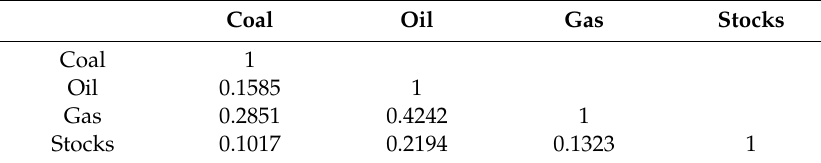
Table 12. Correlations for France.